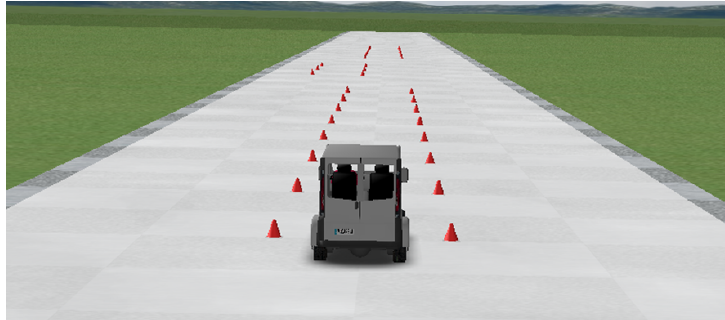
Figure 7. Simulated scenario for a Double Lane Change (DLC) maneuver in Trucksim R (cid:13) .